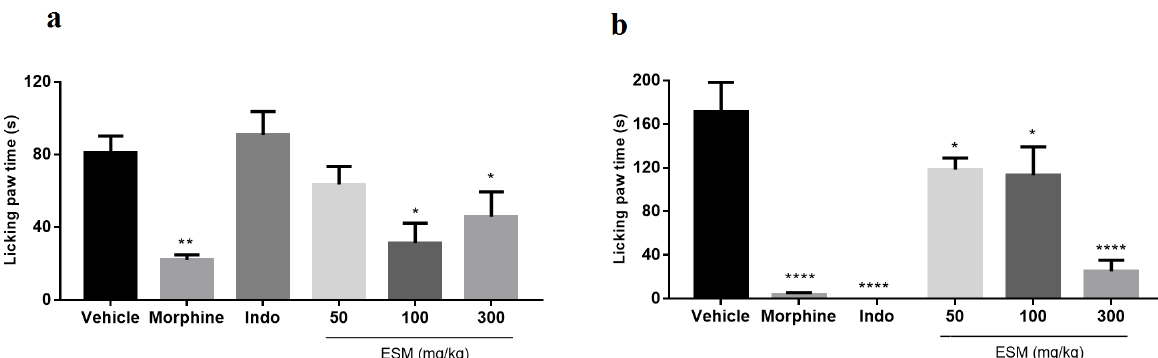
Figure 7. Effect of different doses of ESM on licking paw time in the first (a) and second (b) phases of the formalin test in mice. Vehicle, indomethacin 10 mg/kg and ESM 50, 100, and 300 mg/kg were administered orally, and morphine 7.5 mg/kg was administered intraperitoneally 60 and 30 min before formalin injection, respectively. The licking paw time was counted for 5 min (first phase) and during 15-30 min (second phase) after formalin injection. Each column’s values represent the mean±S.E.M. ANOVA followed by the Tukey test, used as post hoc. Significant values: *p < 0.05 and ****p <0.0001 compared to the vehicle